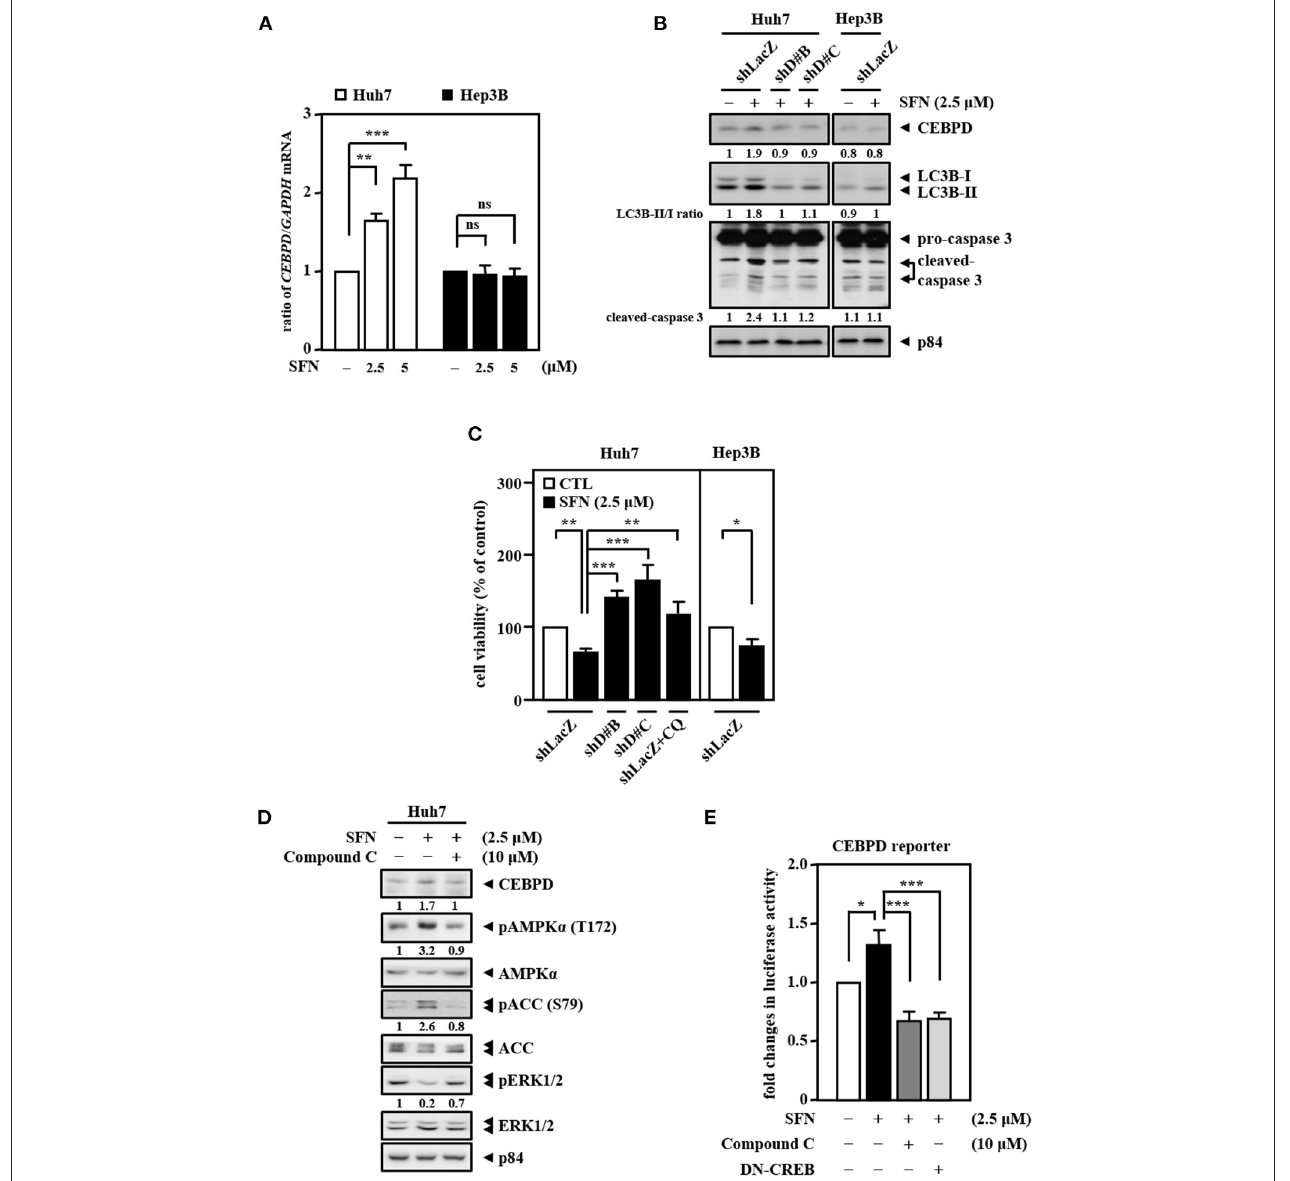
FIGURE 4 | CEBPD is involved in sorafenib-induced autophagic cell death. (A) Huh7 and Hep3B cells were treated with sorafenib at the indicated concentrations for 3 and 24h. Total RNA was harvested for RT-qPCR assays. (B) Huh7 and Hep3B cells were infected with lentiviruses encoding shLacZ (shZ) or shCEBPD (shDB and shDC) and then treated with or without sorafenib (2.5 µ M). Whole cell lysates were harvested for Western blot analyses. (C) Huh7 and Hep3B cells were infected with lentiviruses encoding shLacZ (shZ) or shCEBPD (shDB or shDC) for 3 days. Huh7 cells were pretreated with or without chloroquine (CQ, 10 µ M) for 30min. After being treated with sorafenib (2.5 µ M) for 48h, the cell viability of the infected experimental cells was measured by MTT assays. (D) Huh7 cells were pretreated with or without the AMPK inhibitor compound C (10 µ M) for 0.5h and then treated with or without sorafenib (2.5 µ M) for an additional 6h. Whole cell lysates were harvested for Western blot analyses. (E) Huh7 cells transfected with CEBPD reporters were cotransfected with or without DN-CREB expression vectors for 18h or treated with or without the AMPK inhibitor compound C (10 µ M) for 30min and then treated with or without sorafenib (2.5 µ M) for an additional 3h. The lysates of the transfected cells were harvested for luciferase assays. The data are shown as the mean ± SD. * P < 0.05; ** P < 0.01; *** P < 0.001 by Student’s t